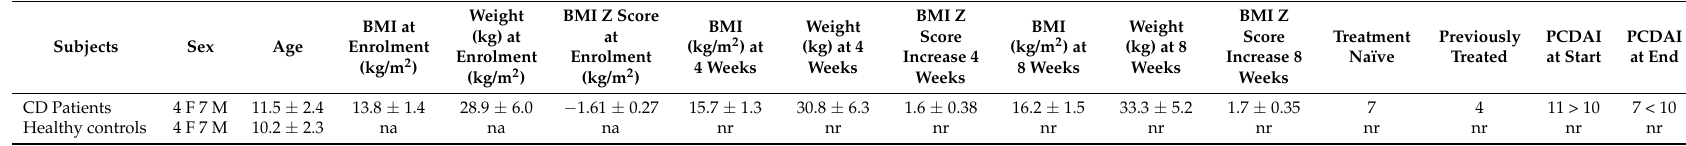
Table 7. Subject data for healthy controls and patients. na = not recorded, nr = not relevant. PCDAI = Paediatric Disease Activity